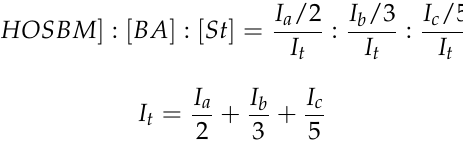
The 1 H NMR spectrum of purified terpolymer HOSBM-BA-St (Figure 2) indicated the incorporation of St units through the appearance of characteristic signals for the aromatic hydrogens at 6.2–7.5 ppm (peak c ). The characteristic signals for the protons of - CH = CH - group (HOSBM) appeared at 5.37 ppm (peak a ). Since the -CH 2 - CH 3 signals of BA at 0.96 ppm (peak b ) overlapped with HOSBM signals -CH 2 - CH 3 at 0.9 ppm the 1 H NMR spectrum of the HOSBM homopolymer was used to calculate the composition for HOSBM-BA-St terpolymers. The molar composition of terpolymers was determined via 1 H NMR spectra based on integrals of these characteristic peaks ( Ia, Ib, Ic ) using Equation (3). The weight fractions were calculated from the mole fraction and presented in Table 1. The amount of BA was calculated by subtracting the integral value of the signals at HOSBM homopolymer spectrum at ~0.9 (3.2) from the determined value.